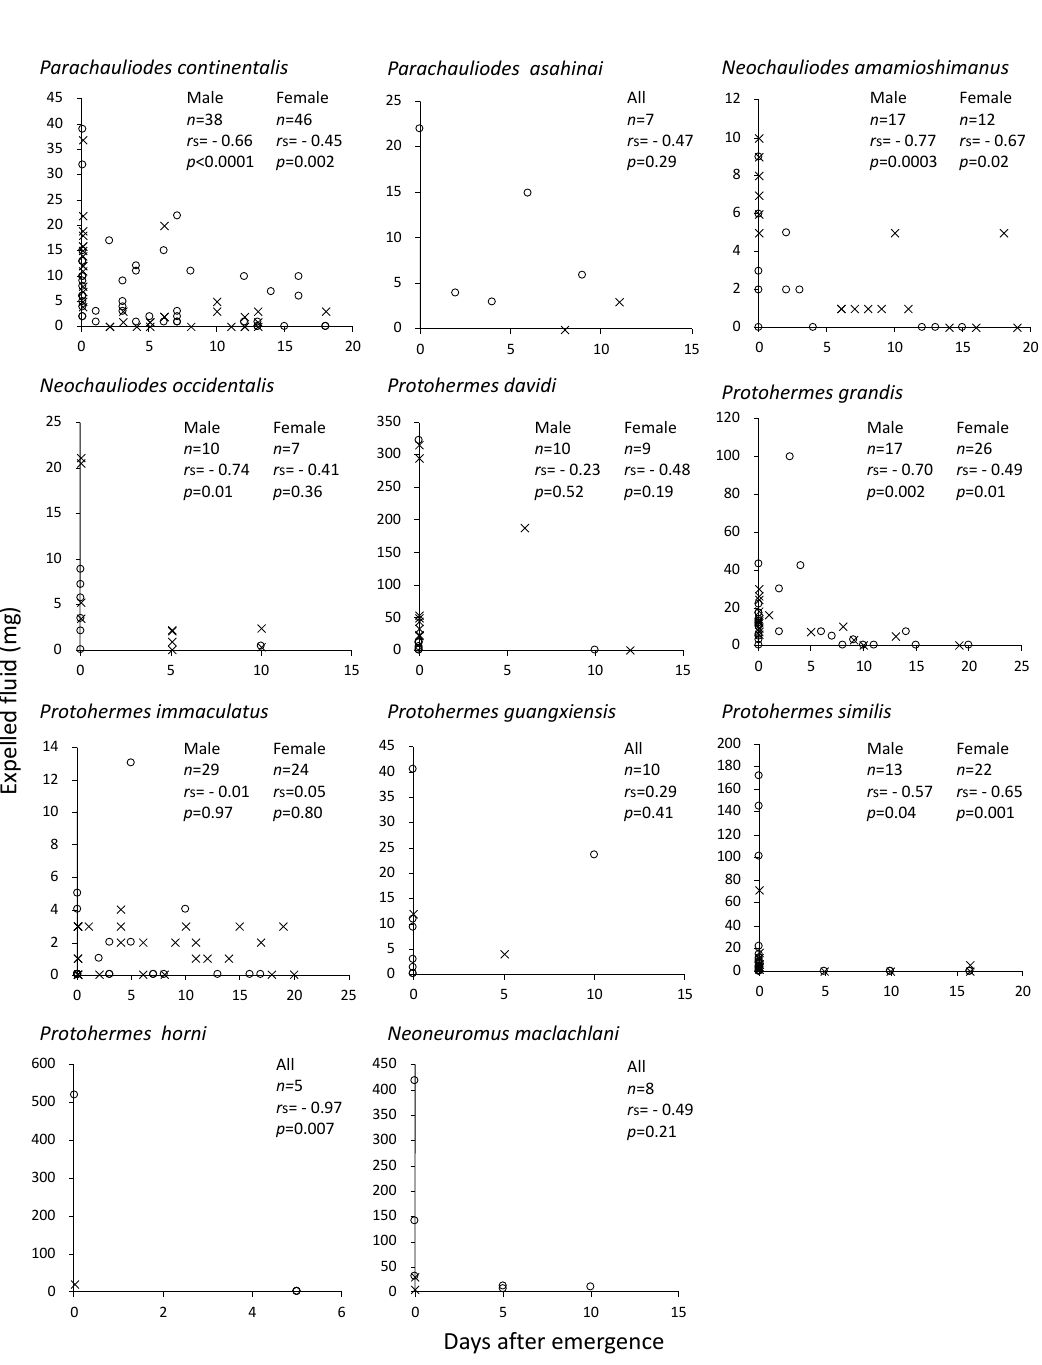
Figure 3. The relationships between adult ages and the amount of expelled fluid in 11 species of male (x) and female (o) fishflies ( Parachauliodes , Neochauliodes ) and dobsonflies ( Protohermes , Neoneuromus ). n : number of individuals examined. r s : Spearman’s rank correlation coefficient. Male and female data are combined in the species with small sample size. Repeated stimulation by hands to the same individuals at 0, 5, and 10 days after although this tendency was not statistically significant in some species (Figure 4). The expulsion fluid seemed to be little